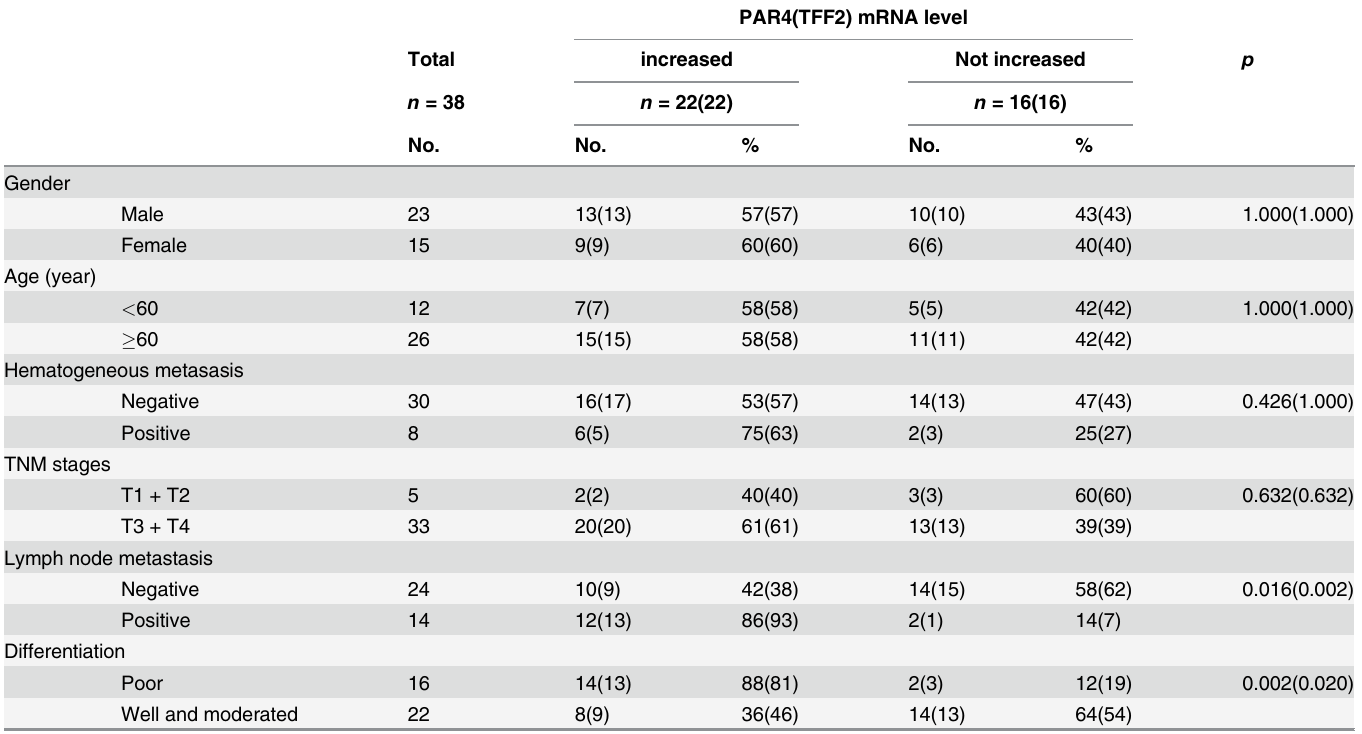
Table 1. Association between the mRNA levels of PAR4 and TFF2 with clinical pathological data of colorectal